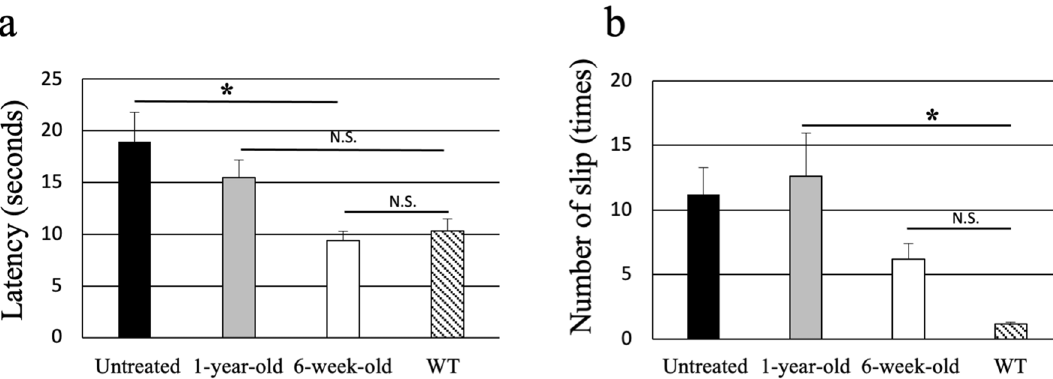
Figure 6. Therapeutic effects of intrathecal injection. Motor function was assessed using a balance beam test with 15-month-old MLD mice left untreated (closed bars, n = 6), treated with AAV9/ARSA at 1 year (gray bars, n = 5), 6 weeks of age (open bars, n = 4) or wild type (WT) (diagonally hatched bars, n = 8). ( a ) Latency: the time required to traverse each beam. ( b ) Slips: the number of times the hind feet of mice slipped off a beam. All animals were given three trials on the beams. *p <